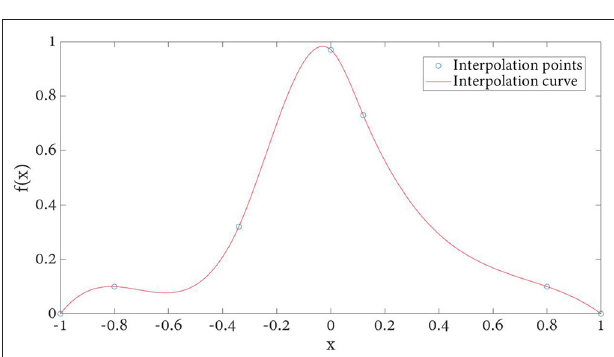
FIGURE 6 | Cubic B-spline interpolation kernel function interpolation